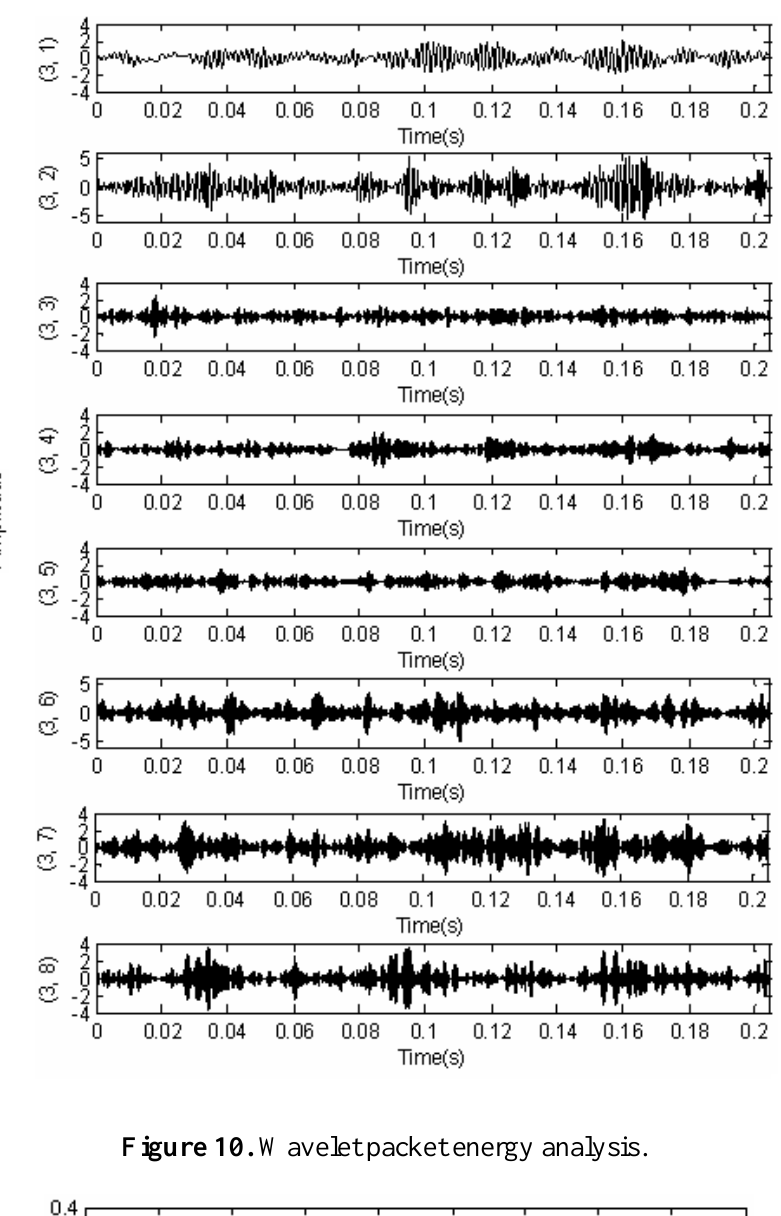
Figure 9. Triple-layer nonlinear redundant lifting wavelet packet decomposition of signals.